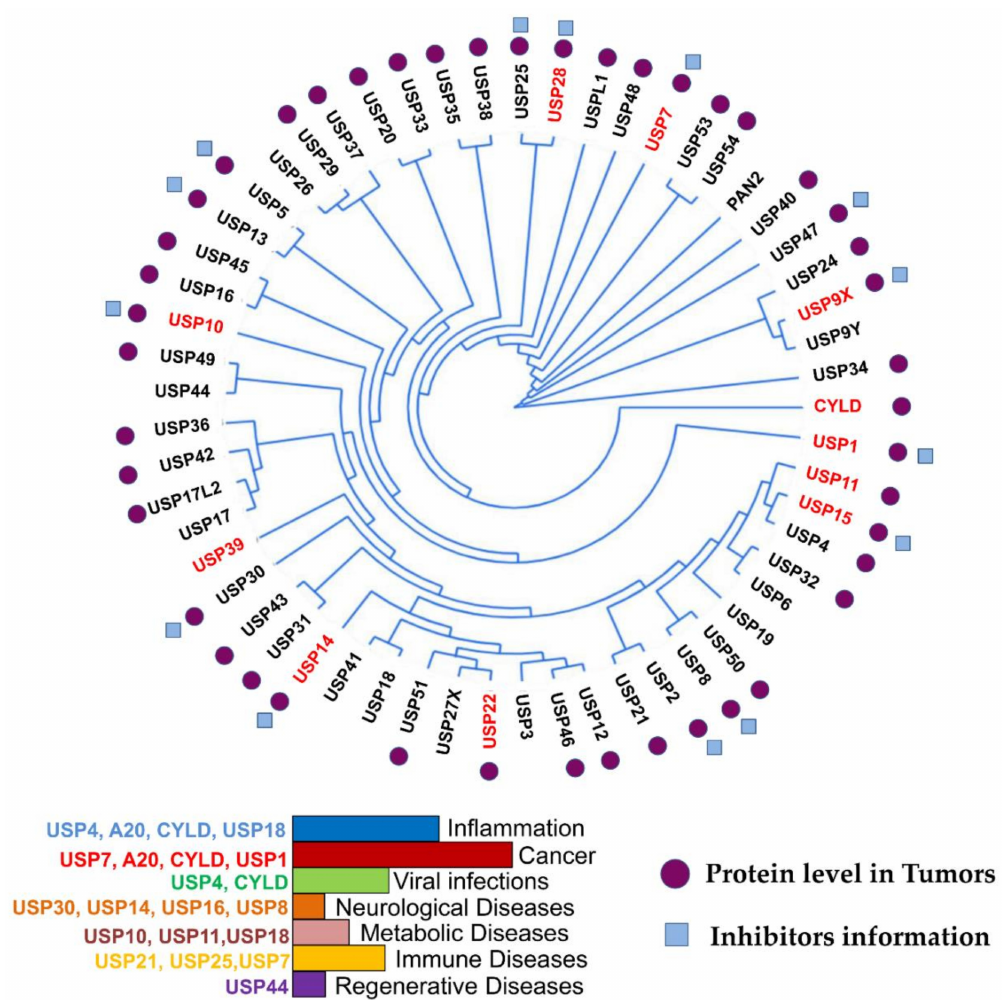
Figure 1. USP phylogenetic tree. Ubiquitin-specific proteases (USPs) and their association with di ff erent diseases are indicated in the histogram. The branches arising from one node represent a clade. The distance between the USPs in the phylogenetic tree describes the relationship among the individuals in this family. DUBs with high expression in di ff erent cancers are highlighted in red in the phylogenetic tree. Tumors expressing medium levels of USPs in di ff erent cancer types are indicated with purple circles. Blue boxes indicate USPs with identified drugs. This figure is a representation of data obtained from at least 1% of cancer patients